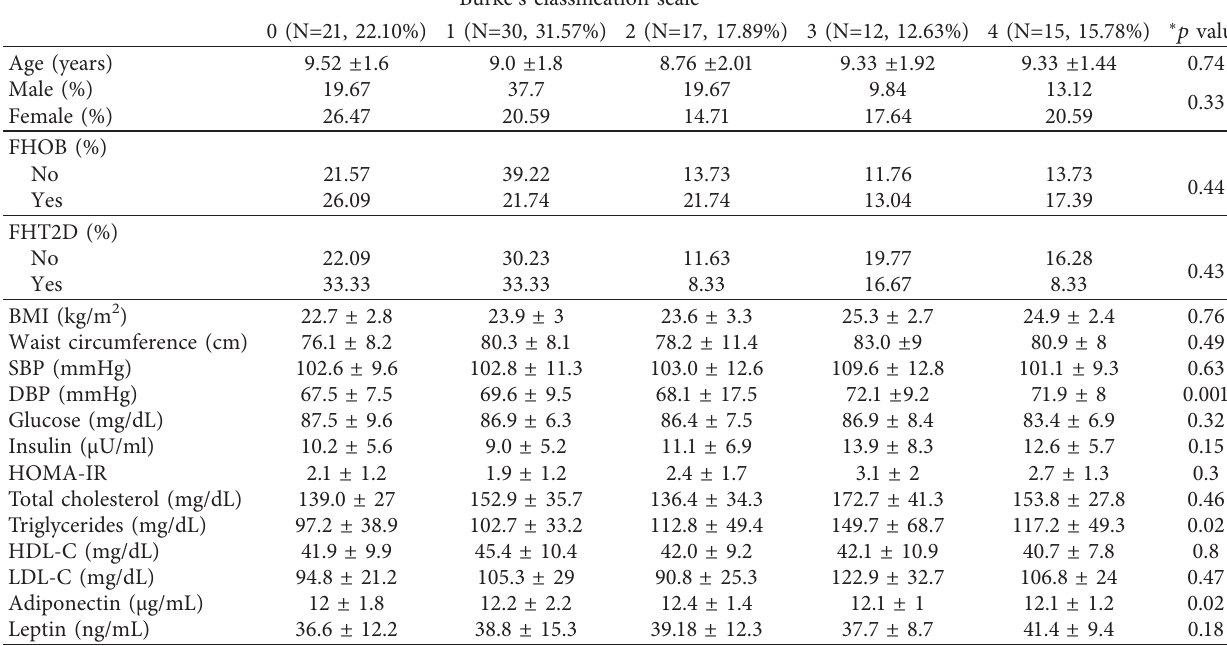
Table 1: General characteristics and clinical, anthropometric, metabolic, and inflammatory profiles by Burke’s classification in obese children.